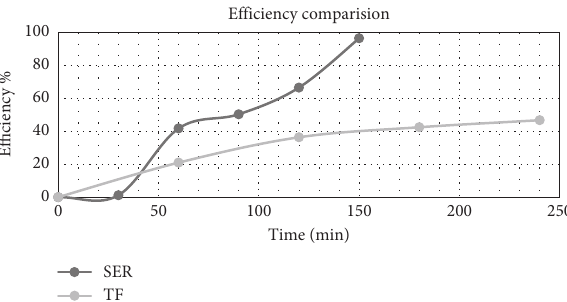
Figure 12: Plot of efficiency with respect to time over 250 min period. It shows the efficiency comparison of SER and